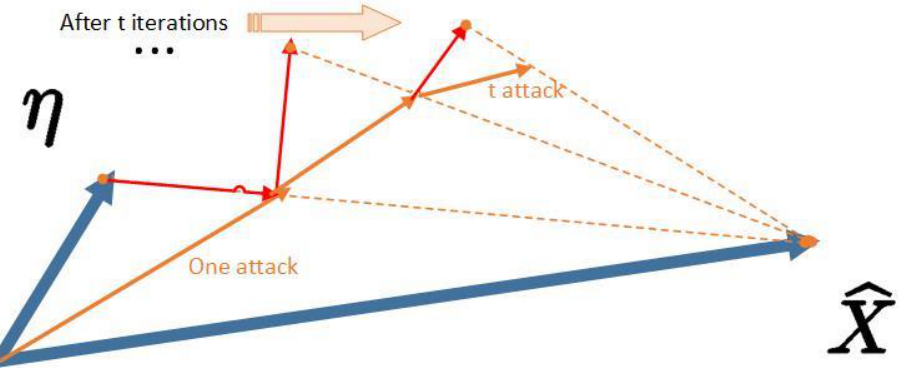
Figure 1. The 𝜂 attack generation process. Figure 1. The η attack generation